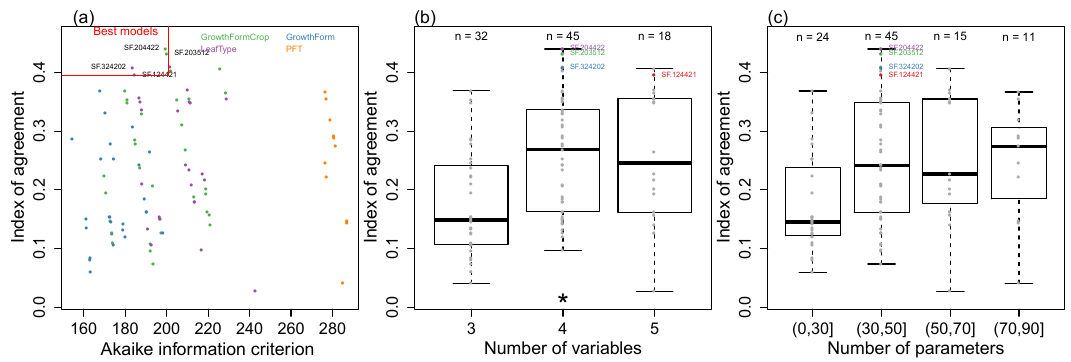
Figure 2. Effect of the complexity of SOFIA models on the performance. Model performance is expressed as the index of agreement between simulated and observed (GFED) monthly burned area time series in the optimization data subset. (a) Scatterplot of the index of agreement against the AIC classified by the used land cover grouping scheme. (b, c) Effect of the number of variables ( = number of controlling factors) and parameters on model performance, respectively. The star symbol in (b) indicates a significantly higher IoA of models, with four instead of three or five variables (Wilcoxon rank sum test, p ≤ 0 . 05). The four best SOFIA models (IoA ≥ 0.395 and AIC ≤ 200) are highlighted by a red box in (a) and by coloured points in (b) and (c)